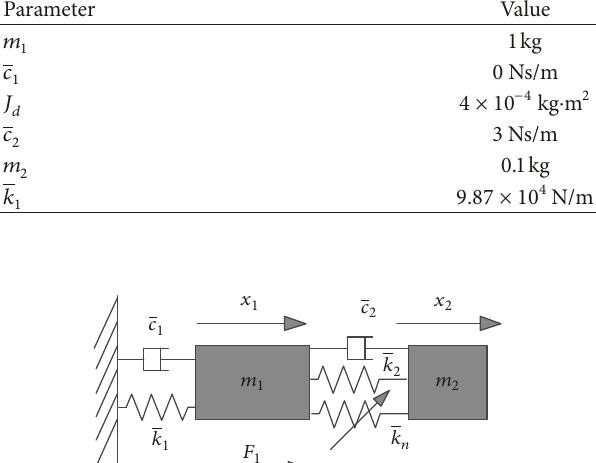
Table 3: Parameters for numerical simulation of the rotor system. Parameter